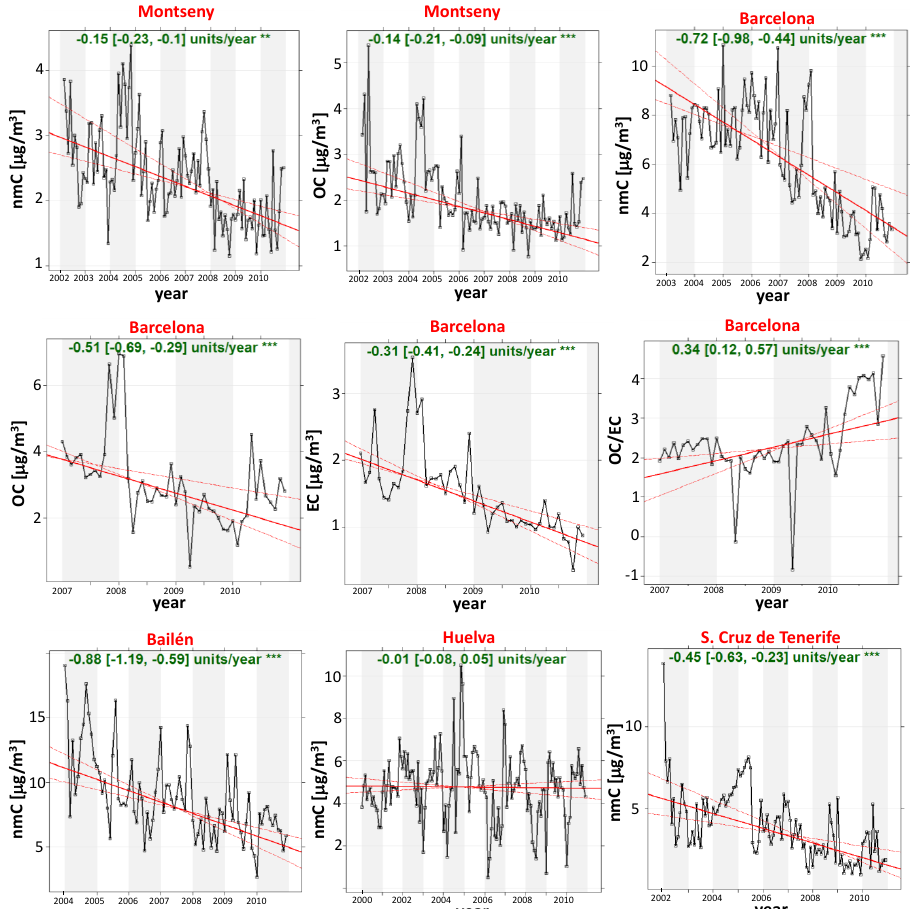
Fig. 6. Temporal trends fornmC in PM 2 . 5 at Montseny, Barcelona, Bail´en, Huelva and Santa Cruz de Tenerife. Plots show the deseasonalized monthly mean concentrations. The solid red line shows the trend estimate and the dashed red lines show the 95% confidence intervals for the trend. The overall trend and the 95% confidence intervals in the slope (between brackets) are shown at the top as units (µgm − 3 ) per year. The ∗∗ and ∗∗∗ indicate that the trend are significant to the 0.01 and 0.001 levels, respectively. The OC concentrations for